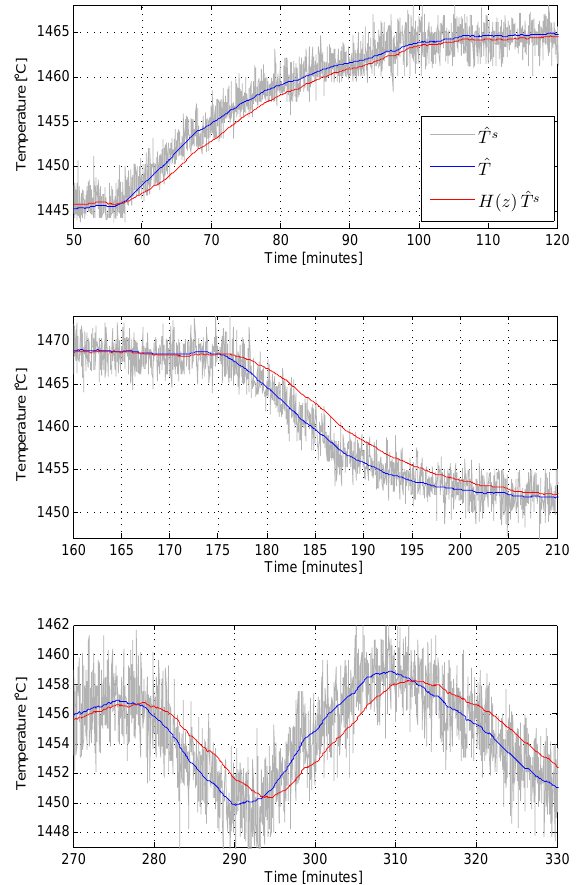
Figure 16: The same data shown in Figure 15, zoomed in at three different areas.